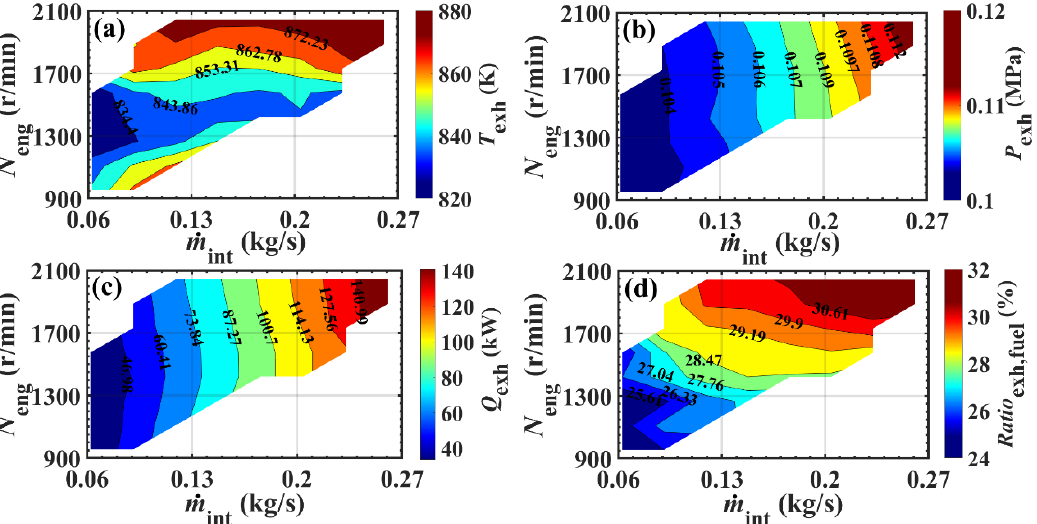
Figure 4. Waste heat characteristics of exhaust in variable working environments. ( a ) Inlet temperature of exhaust. ( b ) Temperature different of exhaust. ( c ) Heat transfer rate of exhaust. ( d ) Proportion of heat transfer rate in exhaust.